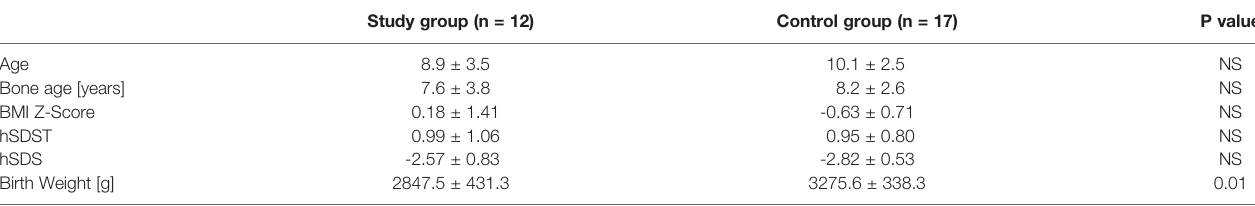
TABLE 1 | Clinical characteristics of the study and control